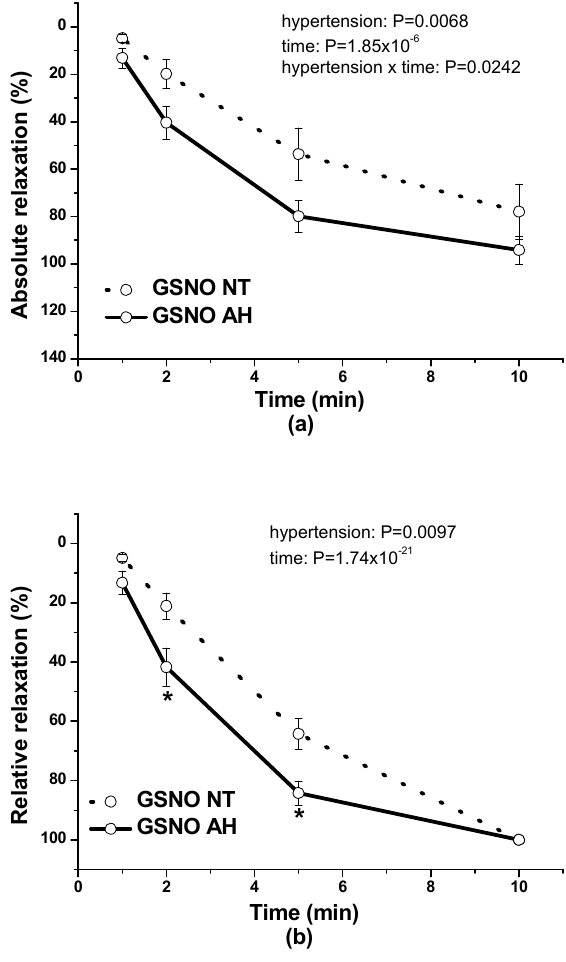
Figure 5. The comparison of vasorelaxations of human lobar arteries induced by GSNO (0.5 µmol/L) between normotensive patients (NT) and patients with arterial hypertension (AH). The absolute vasorelaxant responses are expressed as a percentage of the serotonin (1 µmol/L)-induced contraction ( a ) The relative vasorelaxant responses (revealing the speed of the vasorelaxation) are expressed as a percentage of the maximal relaxation ( b ). Results are expressed as the mean ± S.E.M. Significant differences were evaluated by two-way ANOVA for main factors: hypertension and time. Bonferroni post hoc test was used to describe the differences in mean values of the experimental groups. * p < 0.05 with respect to the value of the GSNO NT response.